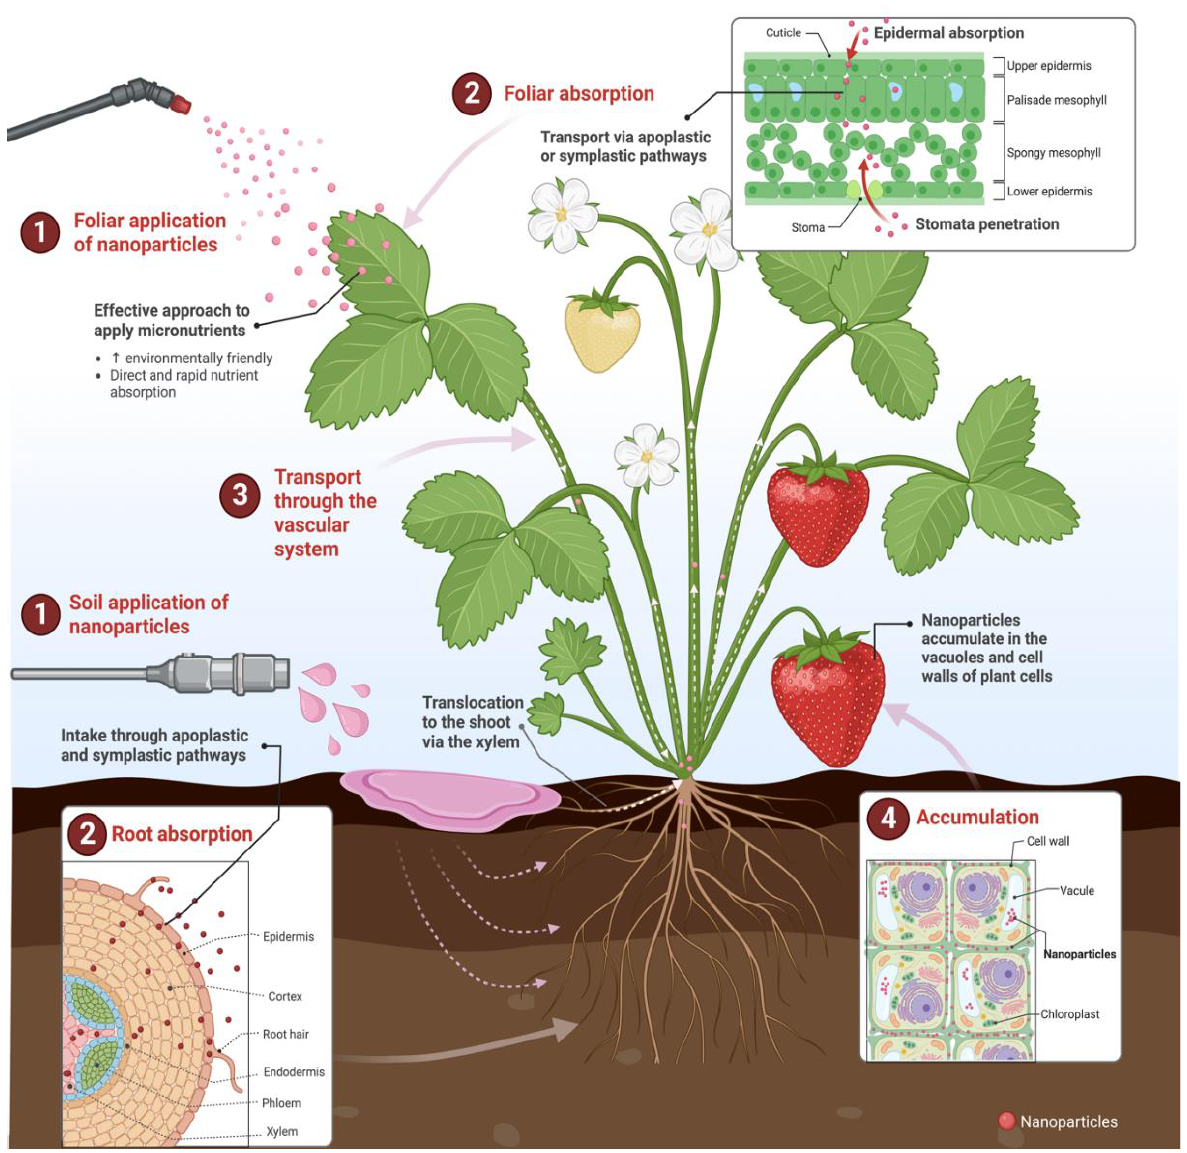
Figure 5. Soil and foliar nanoparticle uptake and transport through plant systems. Figure created with BioRender.com.